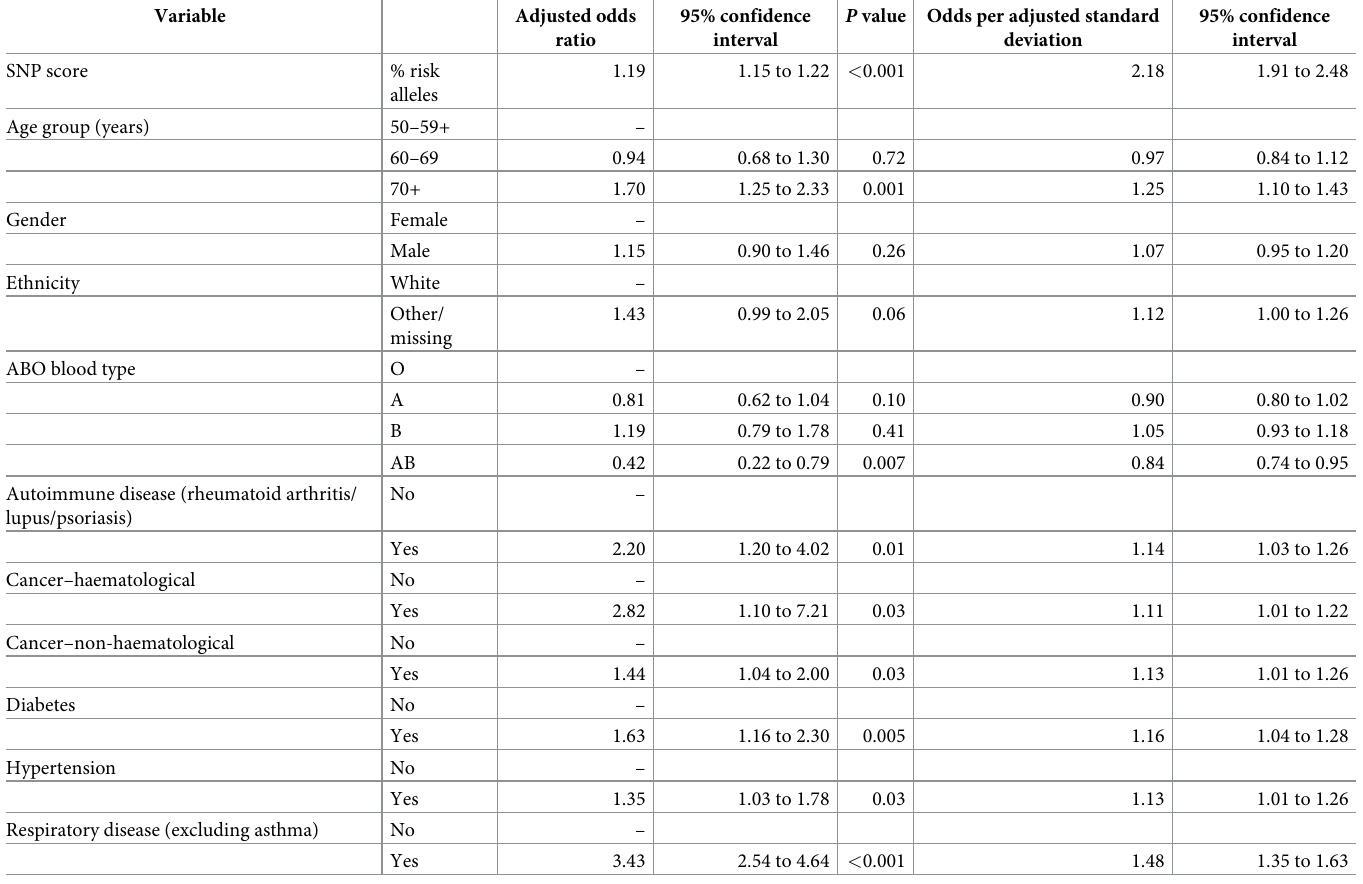
Table 2. Final model for risk of severe